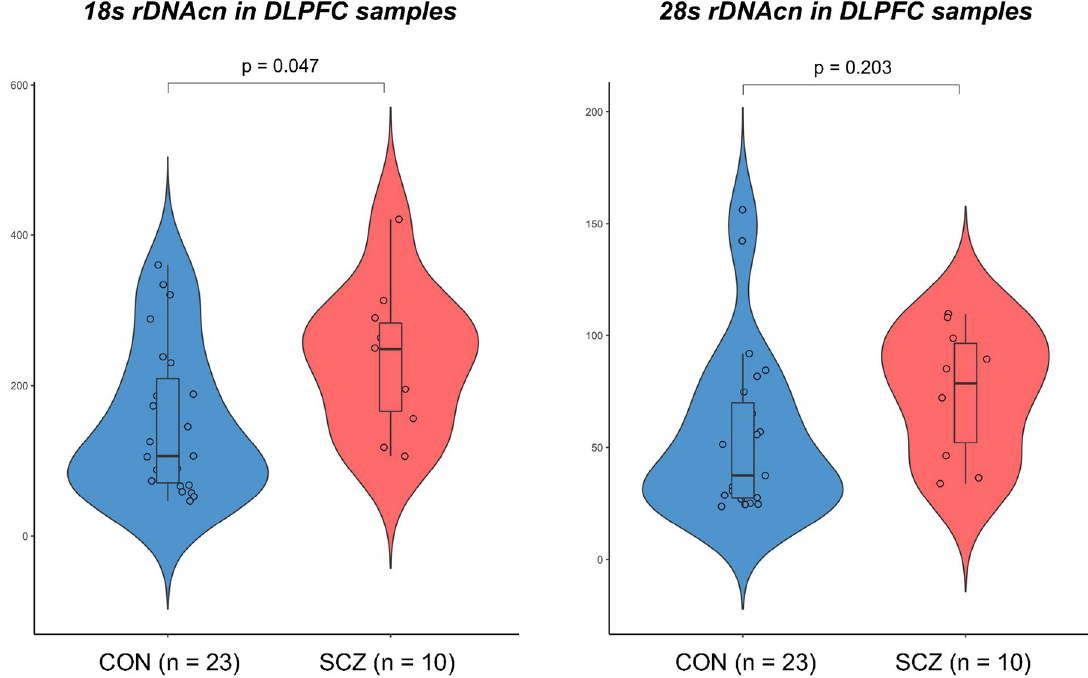
Fig 2. Violin and scatter dot plot including box and whiskers (with minimum to maximum) of 18S/28S ribosomal DNA copy number (rDNAcn) of dorsolateral prefrontal cortices (DLPFCs) in patients with schizophrenia (SCZ) and controls (CON). All p values were adjusted for age and sex as